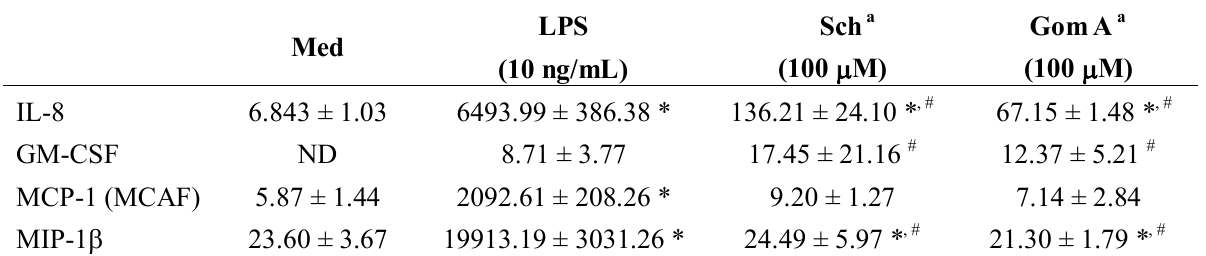
Table 2. Microparticle-based flow cytometric assay (pg/mL) of Schisandra chinensis components. LPS Sch a Gom A a Med (10 ng/mL)